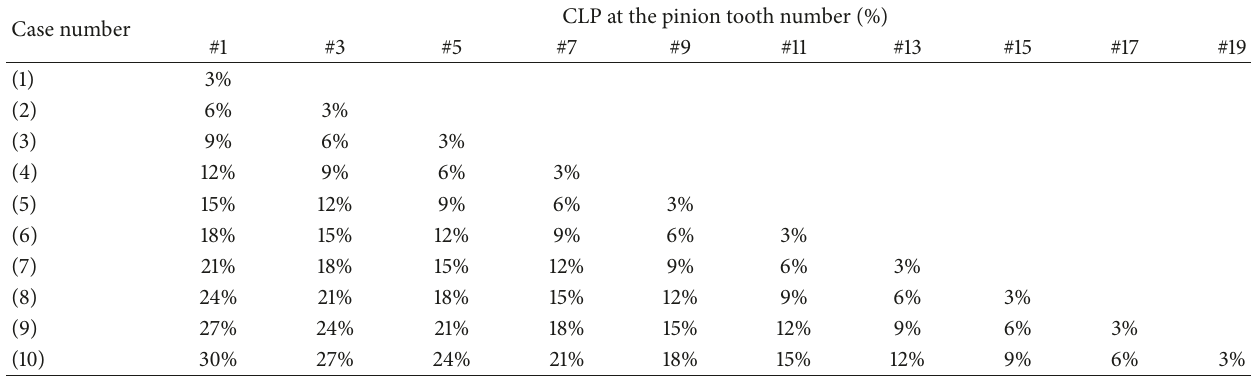
Table 6: Cases for the third scenario with different crack locations and lengths.